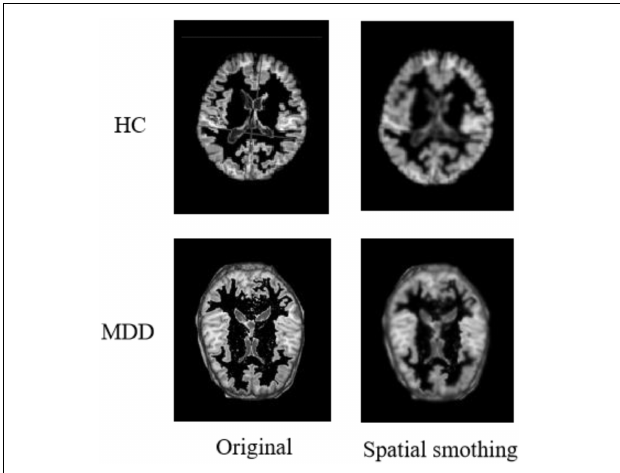
FIGURE 5 | Results of spatial